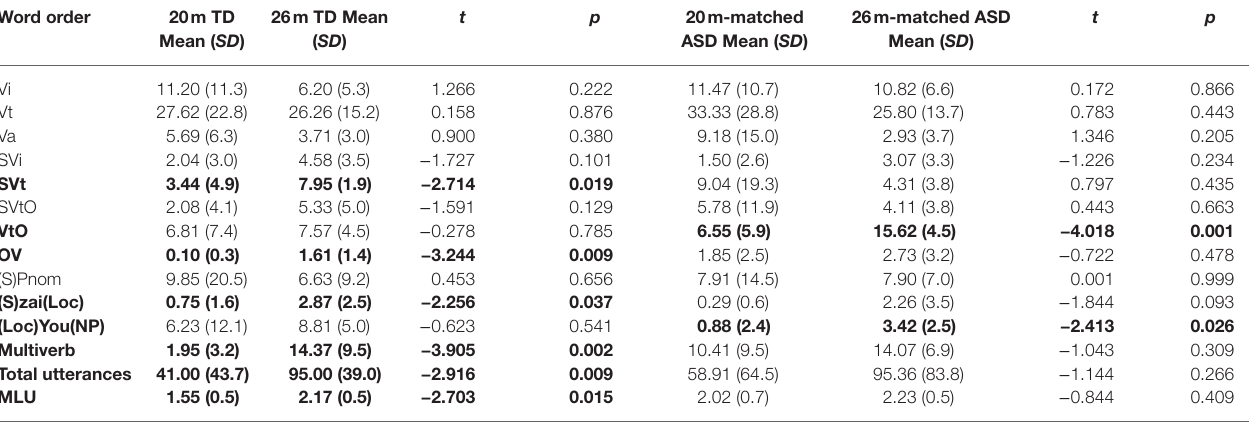
TABLE 3 | Between-group comparison of word order utterances (Children; percent of total utterances). Word order